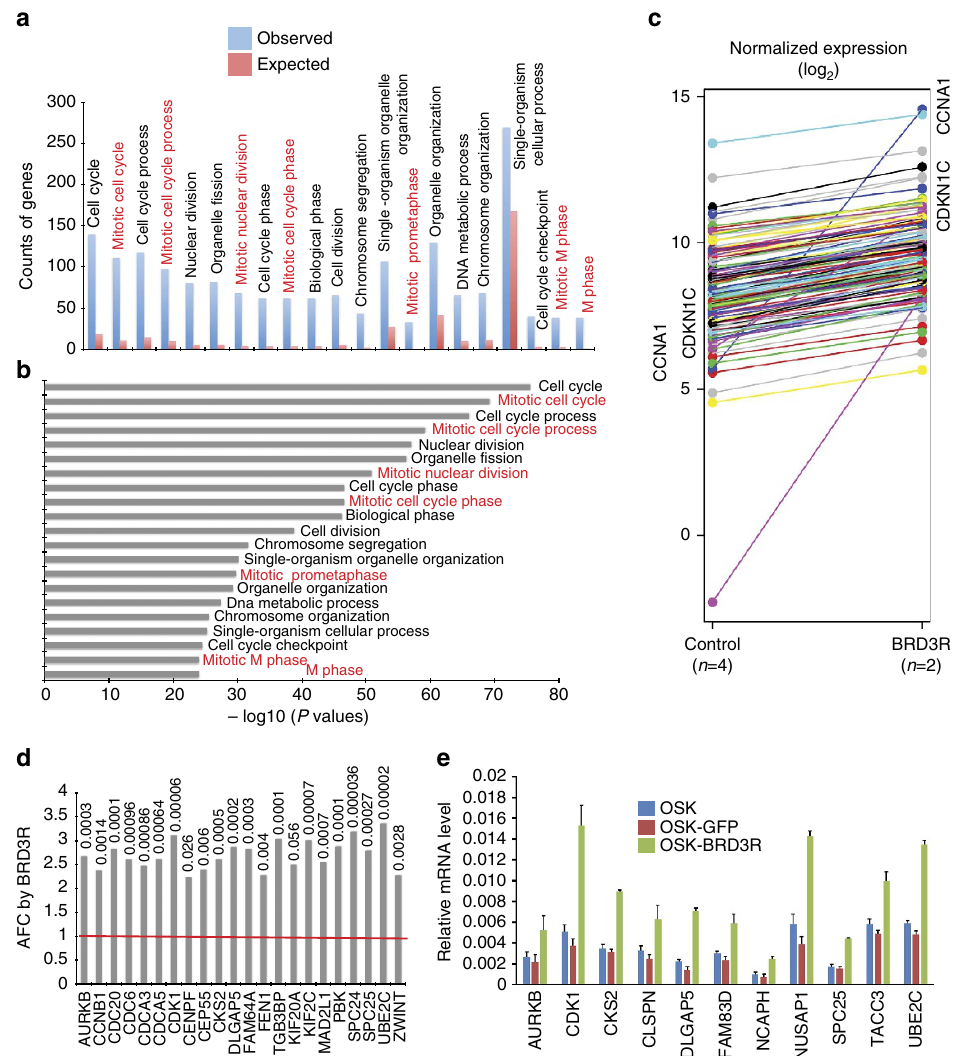
Figure 5 | A Large set of mitotic genes is upregulated by BRD3R during reprogramming. ( a ) Top 21 GO terms for the 335 mapped genes upregulated by BRD3R on day 3 of reprogramming (AFC Z 1.7, P o 0.05, negative binomial (NB) test). Mitotic GO terms are highlighted in red. ( b ) Significance levels for each GO term in a expressed as (cid:3) log 10 ( P values) (binomial test). Mitotic GO terms are highlighted in red. ( c ) Ladder plot of average expression levels showing upregulation of 128 mitotic genes by BRD3R on day 3 of reprogramming (log 2 ; BRD3R, n ¼ 2; control, n ¼ 4). ( d ) AFC for the 24 mitotic genes listed in Supplementary Data 1. Red line, no-change level. Numbers above bars are the corresponding P values (NB test). Upregulation of CCNA1 and CDKN1C are apparent in c . ( e ) RT–qPCR verification of 11 mitotic genes randomly selected from the 185 BRD3R-upregulated mitotic genes ( n ¼ 3, mean ±